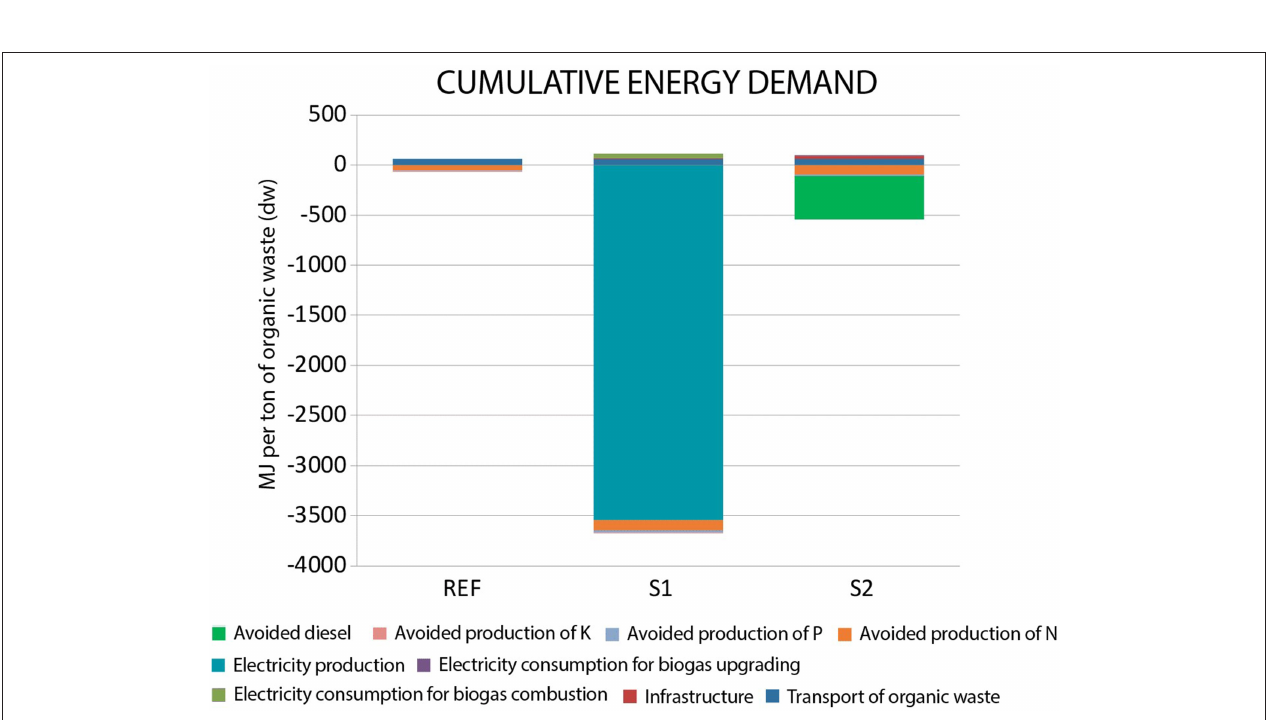
FIGURE 5 | Comparison of the reference and alternatives scenarios for the category of cumulative energy demand. Results are displayed as equivalent kg of CO 2 per ton of dry weight organic waste.